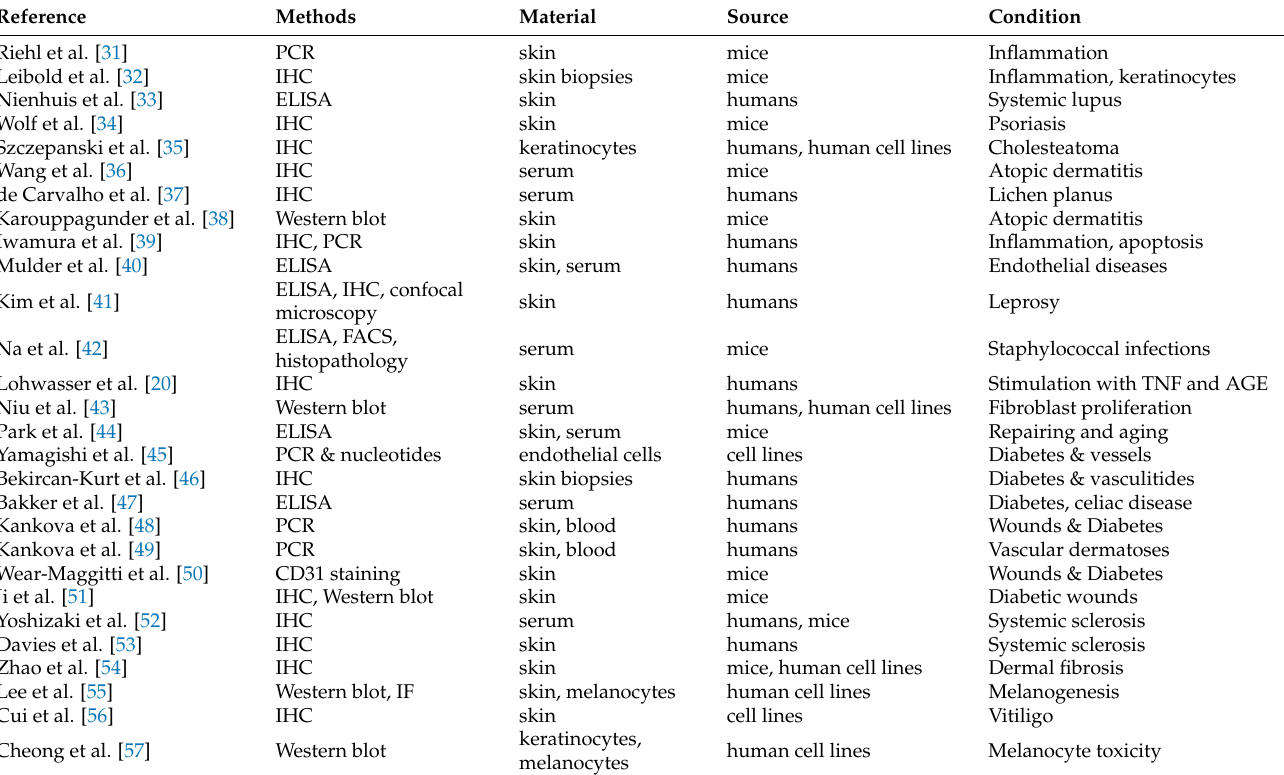
Table 1. Summary of methods, materials (and their sources), and conditions examined in the studies included in the review.